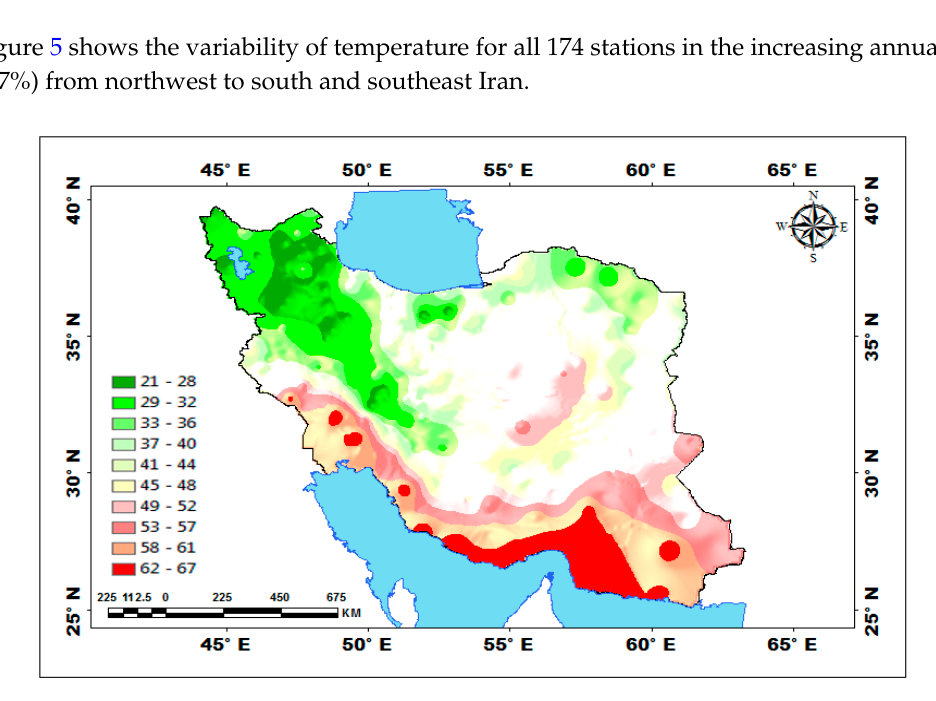
Figure 5. The coefficient of variations of Annual Temperature (%).